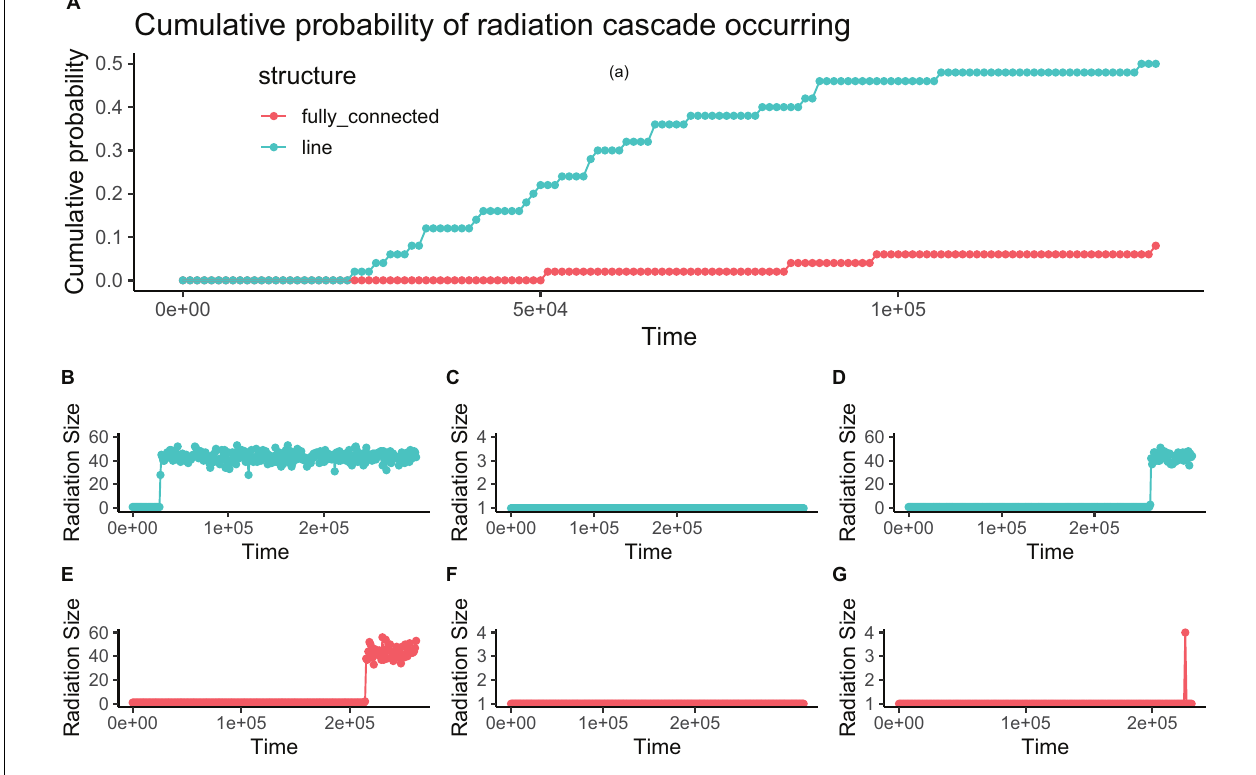
FIGURE 7 | Example time series of radiation size (panels B–G ) showing radiation cascades occurring in some simulation runs, but not in others with the same parameters. Two extreme scenarios are possible: the radiation can be very large or non-existent. After a radiation cascade has occurred, it cannot easily be reversed. The cumulative probability for a lineage to undergo a radiation cascade increases but shows that in some cases the cascade may not occur for a long time (panel A ). Blue lines represent results from a line-structured network of local patches and red lines represent results from a fully connected structure of local patches. The figure was produced with gene flow effect (G) equal to 0.1 and community network containing 4 patches each with 1000 individuals, within the network, the internal dispersal rate (m) was